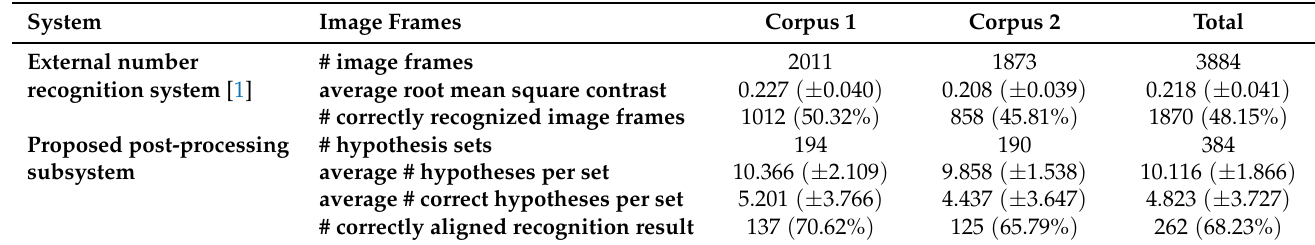
Table 3. Image frame corpus and recognition accuracy.